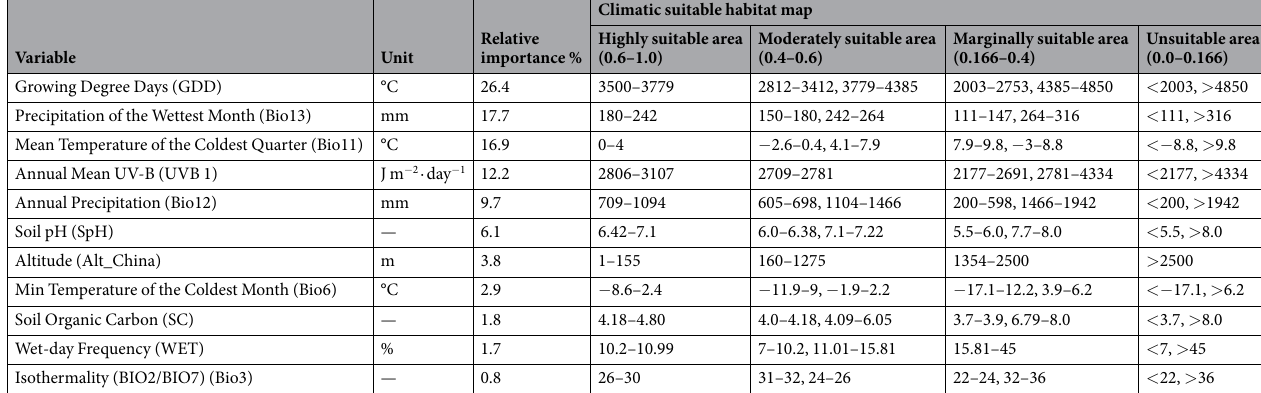
Table 1. Percentage of variable contribution to the model construction derived from the permutation importance analysis and the ranges of the 11 environmental variables across the four habitat classes.